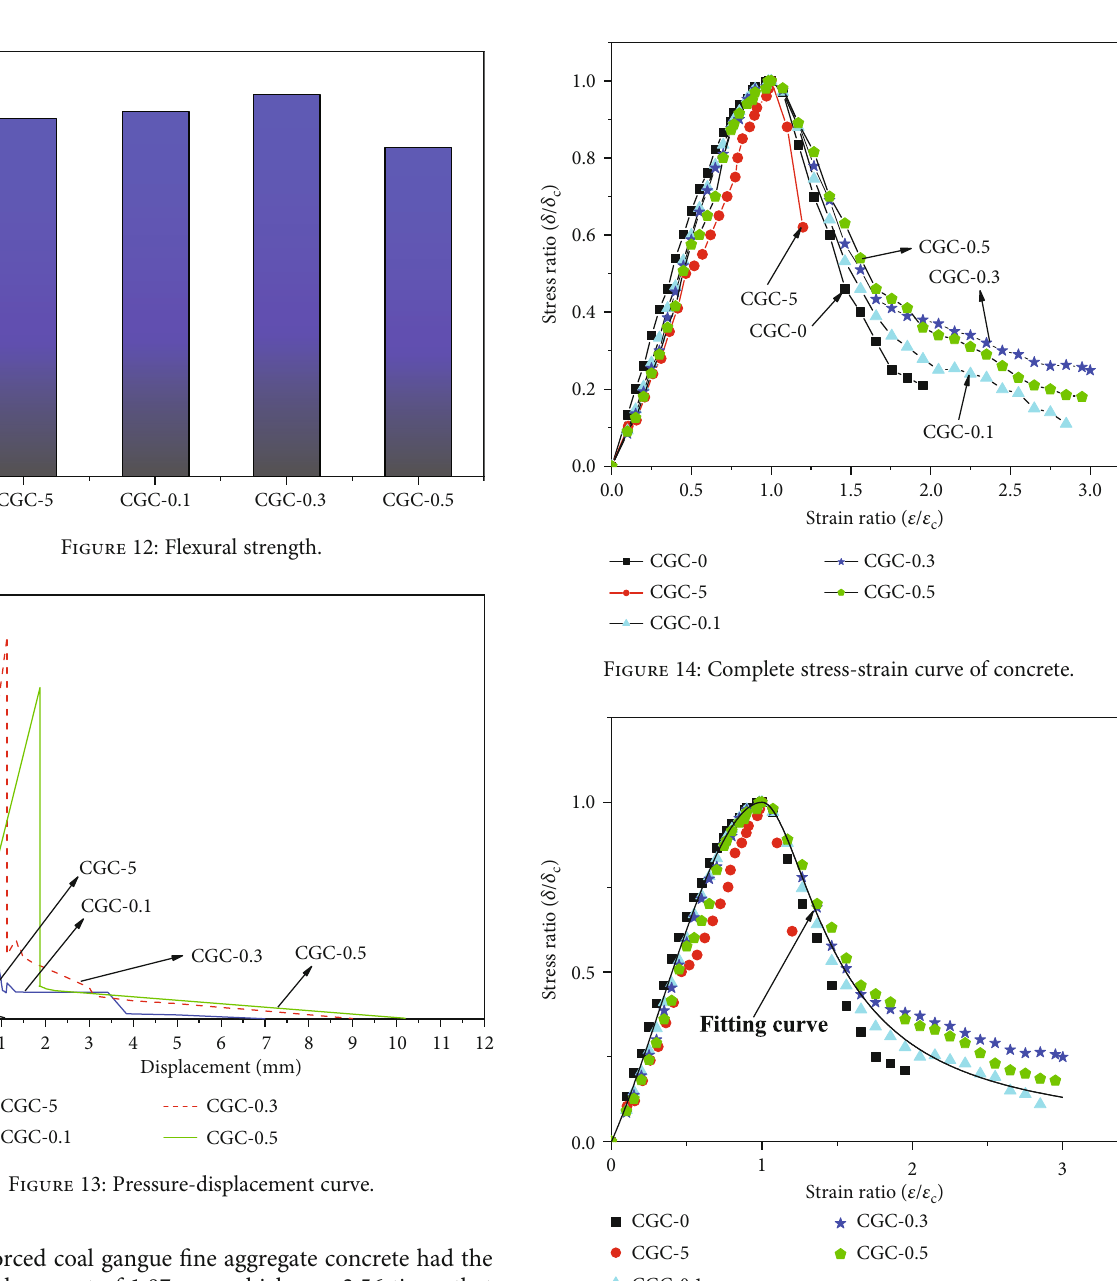
Figure 15: Fitting curve of the stress-strain constitutive equation of